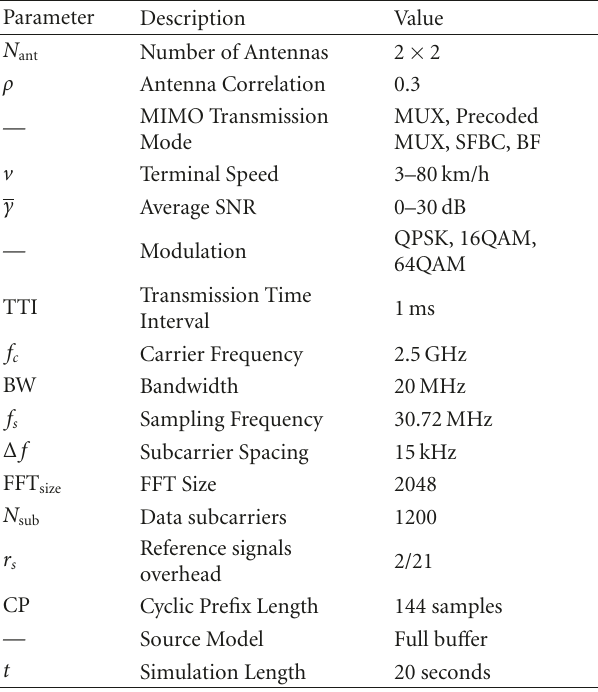
Table 1: Simulation parameter